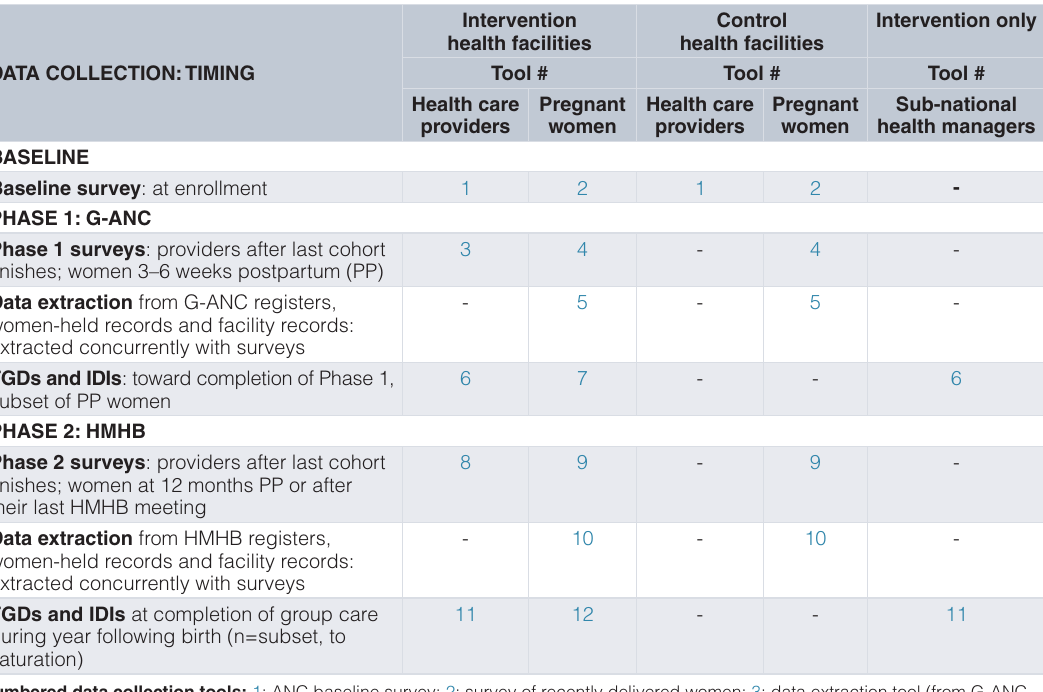
Table 6. Data collection timing and tools, by trial phase. Summary of the timing of when each data collection tools stratified by study phase